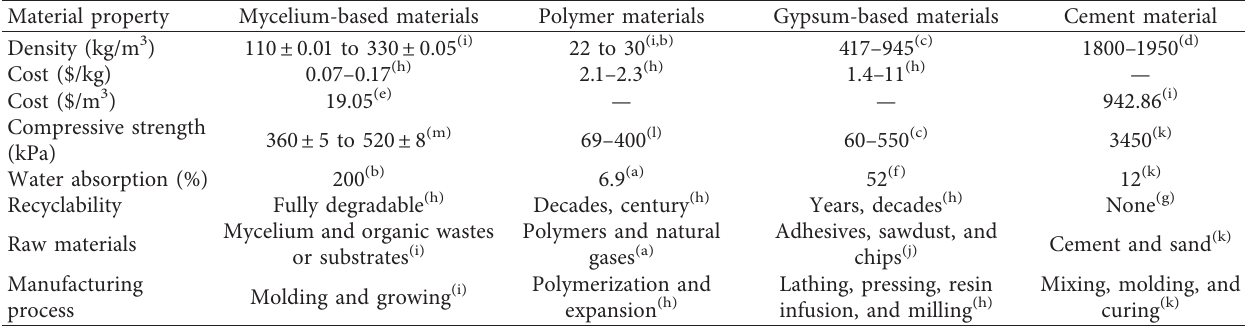
Table 3: Comparison of MBB in cost, strength, density, recyclability, and manufacturing method with the conventional construction